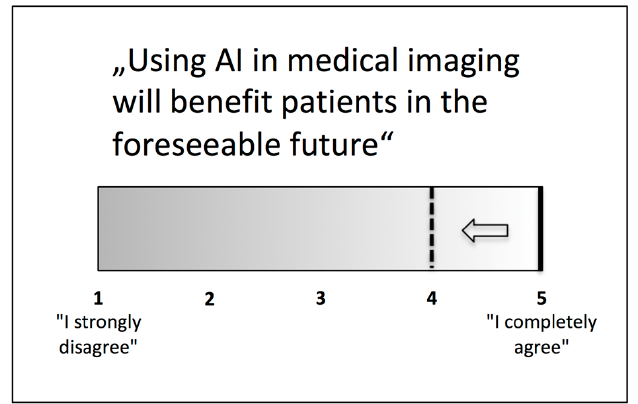
Figure 2. Median agreement with the statement “Using AI in medical imaging will benefit patients in the foreseeable future” changed from full to partial after the